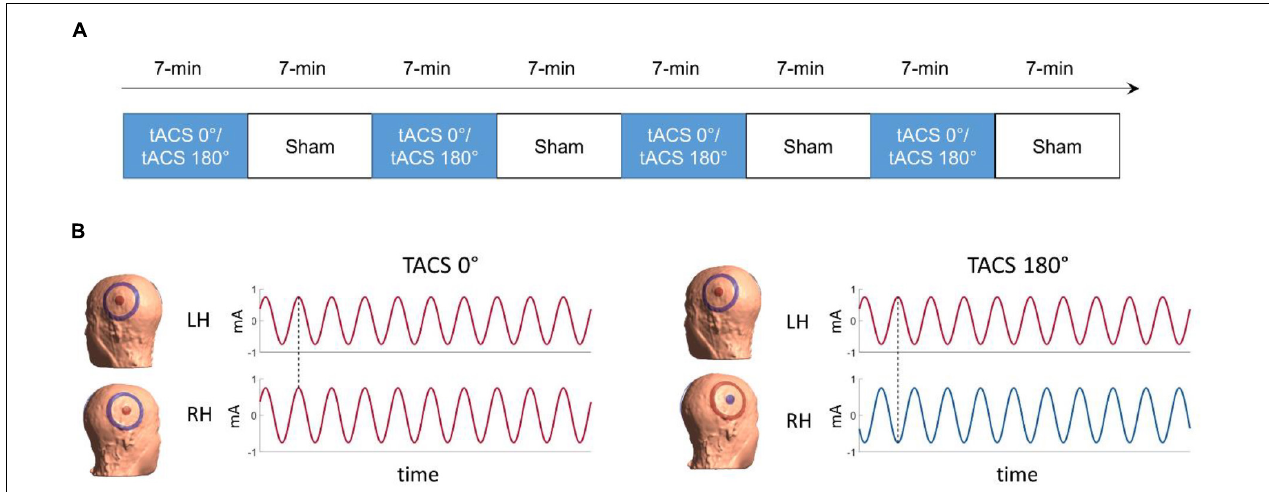
FIGURE 1 | (A) Time-course of the experiment (B) illustration of the tACS conditions. On the left side, in-phase tACS with an interhemispheric phase lag of 0 ◦ (tACS 0 ◦ ), on the right side anti-phase tACS with an interhemispheric phase lag of 180 ◦ (dotted line, tACS 180 ◦ ). The colors represent the polarity (positive = red; negative = blue) of the current for the time stamp highlighted by the dotted